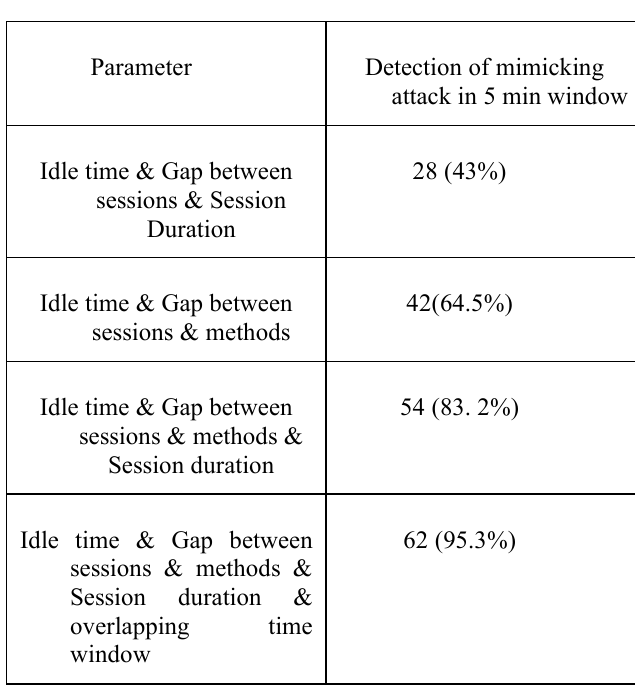
Table 2. Mimicking attack identification by combining multiple